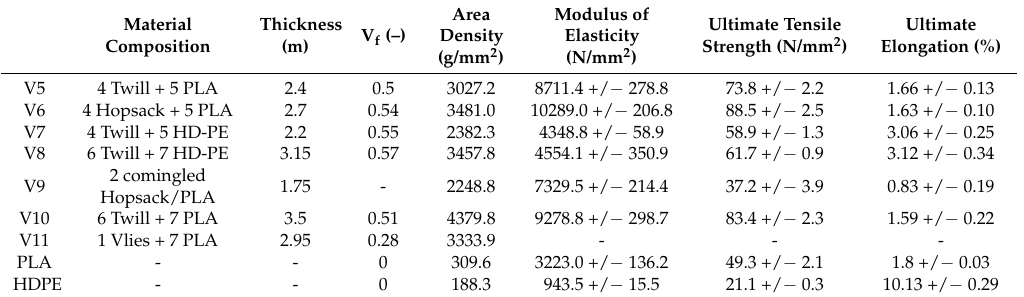
Table 1. Material characteristic and mechanical properties of the materials that were tested.